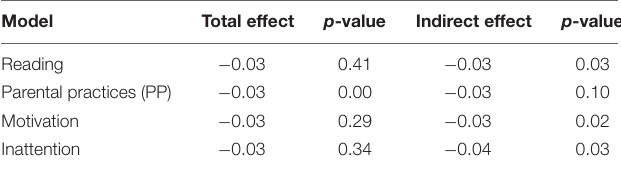
TABLE 7 | Indirect and total effects.